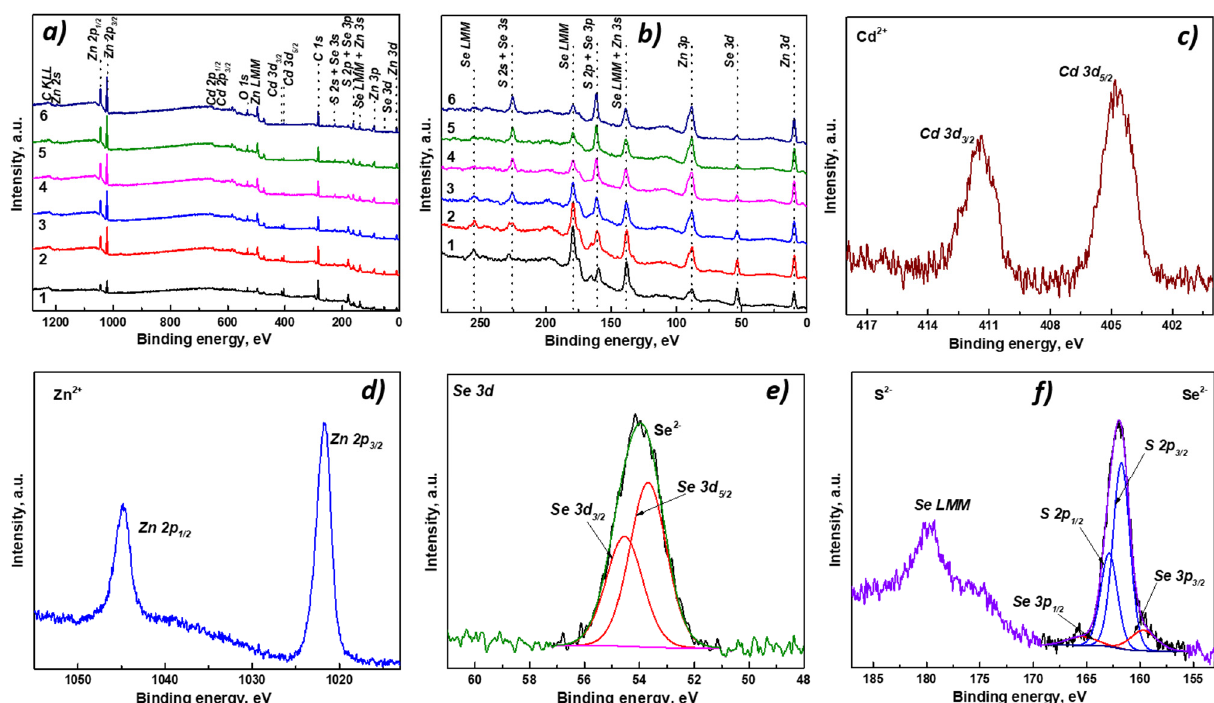
Figure 6. XPS survey spectra of core/shell Cd 0.25 Zn 0.75 Se/ZnS QDs with different shell thicknesses (1—Cd 0.25 Zn 0.75 Se core, 2—ZnS 1 ML, 3—ZnS 2 MLs, 4—ZnS 3 MLs, 5—ZnS 4 MLs, 6—ZnS 5 MLs) ( a , b ); chemical state analysis of Cd 3d ( c ), Zn 2p ( d ), and Se 3d ( e ), and strong overlap between S 2p and Se 3p ( f ) .